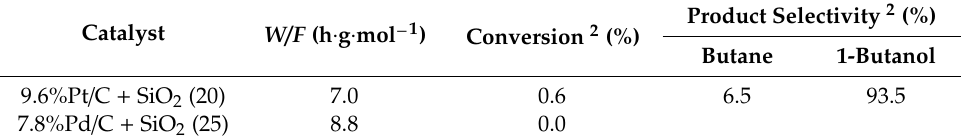
Table 3. Hydrogenolysis of tetrahydrofuran 1 .